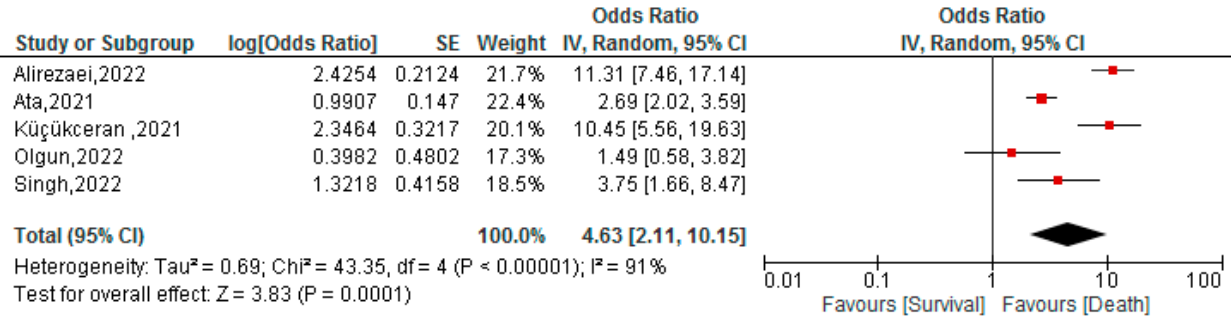
Figure 5. Association between BAR and mortality of COVID-19 patients [46–49,51].